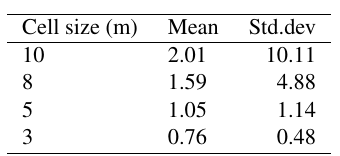
Table 2: Mean and Std.dev. of the distances